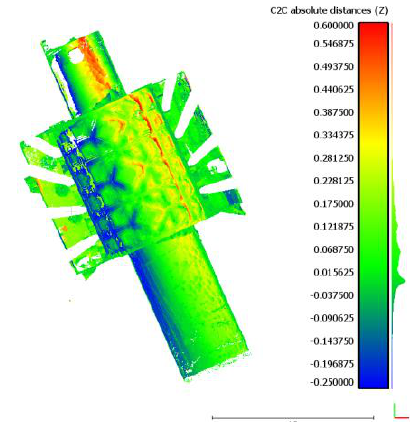
Figure 10 . Distances along the Z axis resulting from the Cloud- to-Cloud application, registration was applied (by setting shift in the three directions x, y, z and rotation with respect to the z axis) of the two point clouds.